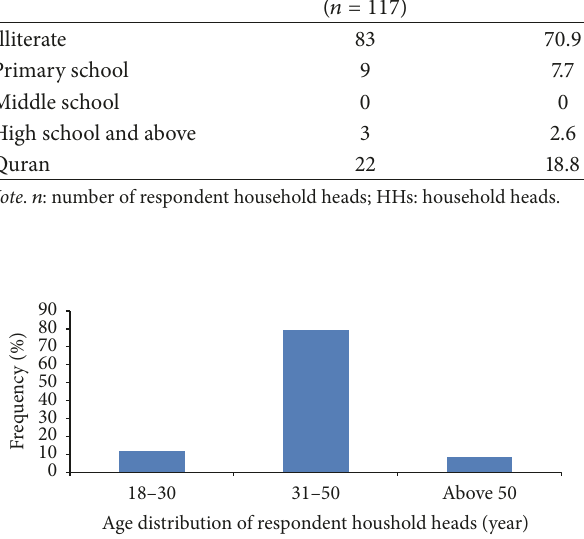
Figure 1: Age distribution (%) of the respondent households in the study